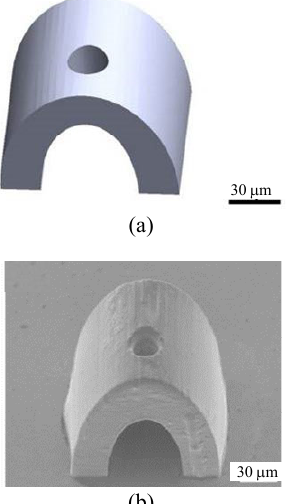
Fig. 3 Preparation of “arch bridge” shaped microstructures: (a) 3D design of microstructures and (b) SEM images of 40-fold